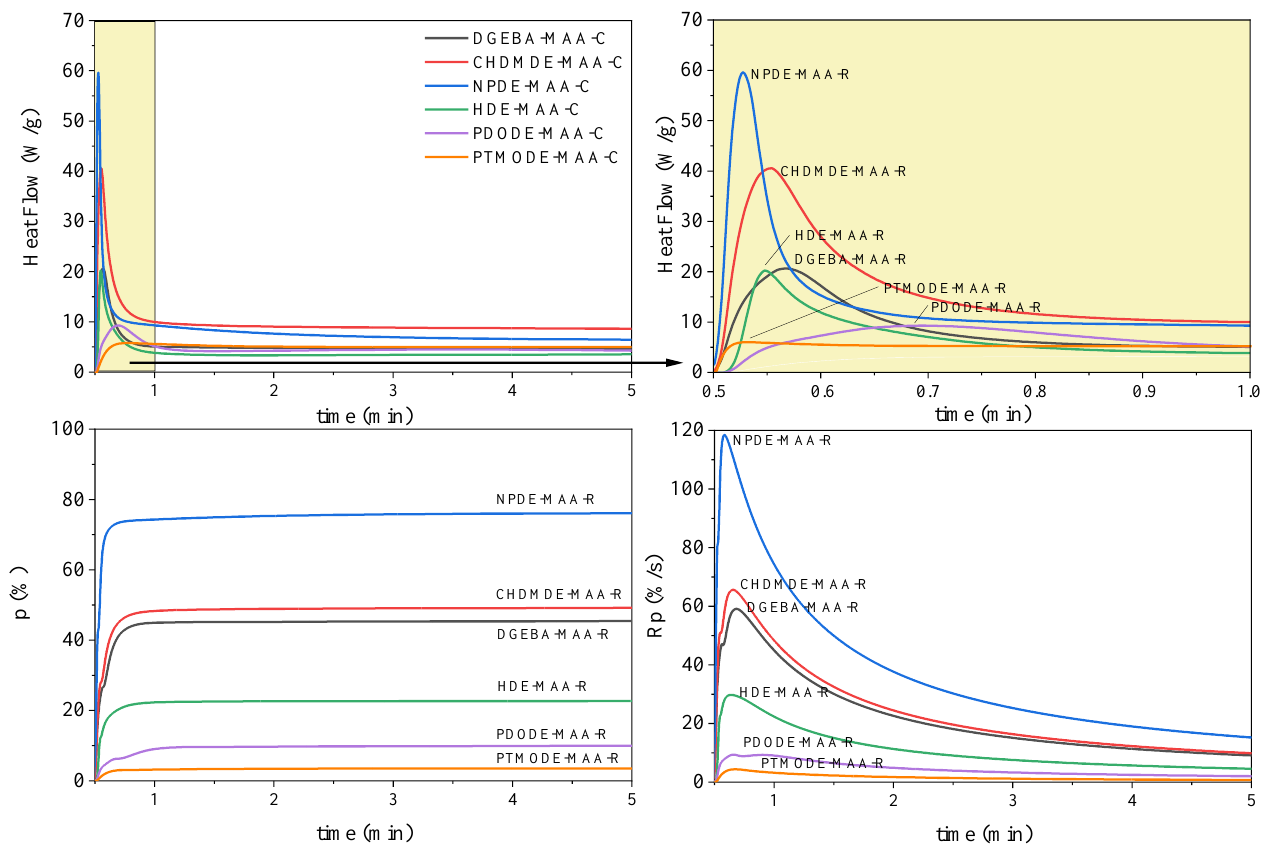
Figure 4. Photo-DSC exotherms for the radical (R) photopolymerization of epoxy methacrylate formulations (diglycidyl ether-MAA). Table 3. Characteristic of the photocuring process of epoxy methacrylate pre-polymers.